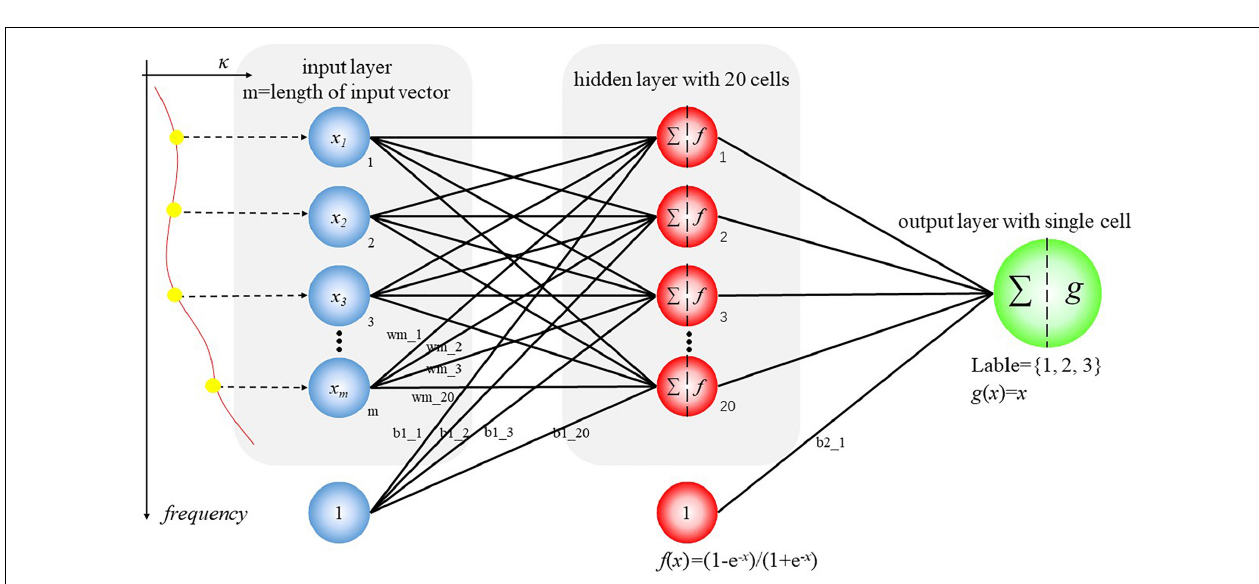
FIGURE 1 | Schematic of terahertz time-domain spectroscopy. It shows the basic optical configuration of a typical terahertz time-domain spectroscopy. Time delay is needed to scan THz pulse with femtosecond laser pulse. Photo conductive antenna is the key component to emit THz wave that is pumped by a femtosecond laser. GaAs is the key component to detect THz wave owing to Pockels effect. Waveplate and Wallaston prism are used to isolate beams with different polarization directions, which are further detected using circuit.